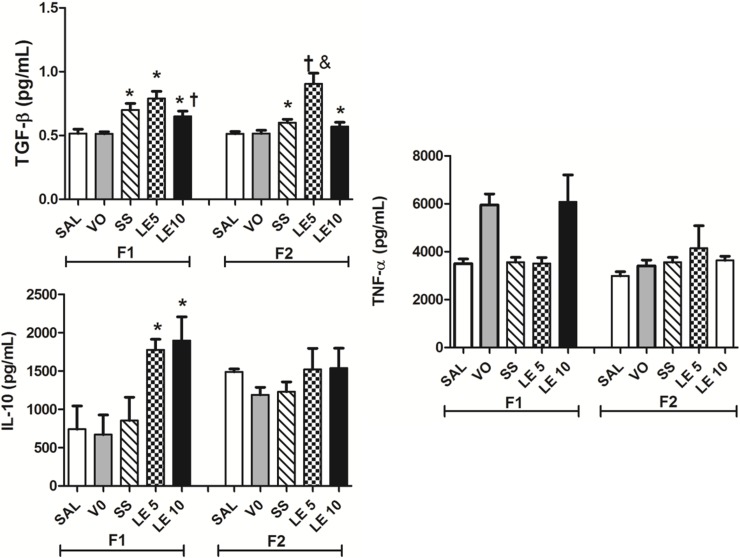
Levels of transforming growth factor beta (TGF-β), Interleukin 10 (IL-10) and tumor necrosis factor (TNF-α) in scar tissue of rats treated with Strychnos pseudoquina extract.F1: treated tissue after seven days, F2: treated tissue, after 14 days. Sal: saline solution, OV: vehicle, SS: silver sulfadiazine, LE 5: S. pseudoquina 5%; LE 10: S. pseudoquina 10%. Data represented as mean ± SD. *† p<0.05, statistical difference between treatments: * vs. Sal and OV, *†vs. Sal, OV and SS (Kruskal-Wallis test).